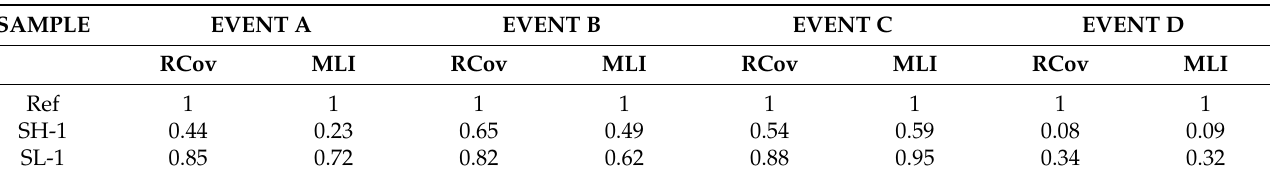
Table 8. RCov and MLI for SH-1 and